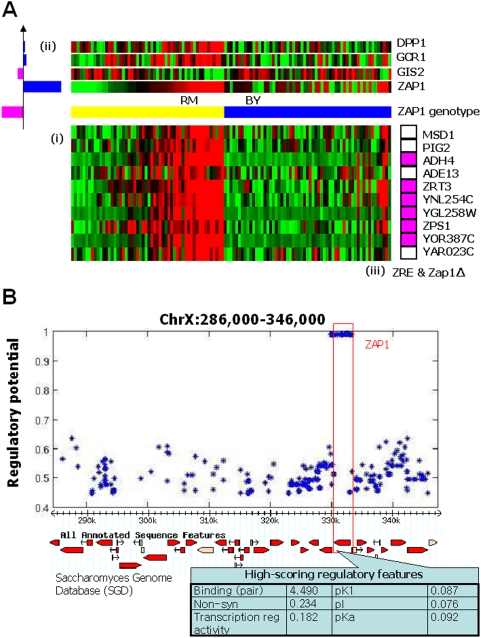
The Zap1 module.(A) (i) The mRNA expression profiles (log2 ratios) of the module's 10 target genes, where the rows are genes and the columns are strains. (ii) The module is regulated by five predicted regulators, where the two that have the most significant coefficients are the expression pattern of ZAP1 and a genetic region on chromosome 10 containing ZAP1. The bar on the left of each regulator represents its coefficient in the regulatory program: the length encodes its absolute value, purple represents a negative weight and blue a positive one. (iii) Six of the target genes (ADH4, ZTR3, YNL254C, YGL258W, ZPS1/YOL154W, and YOR387C) were identified as probable Zap1 targets based on the presence of a consensus ZRE element and RNA expression patterns [27]. (B) The genetic region on chromosome 10, with the inferred regulatory potentials for each of the SNPs it contains (Table S7). Also shown are the regulatory features that contributed the most to the selection of a SNP in Zap1 as the causal polymorphism: a known binding relationship between Zap1 and two of the target genes, the presence of non-synonymous coding changes and their effect on various protein properties, and the gene's annotation as having transcriptional regulator activity. All the other minor regulators of this module (Dhh1, Gcr1 and Gis2) are not located in this region; they are in chr 4, 16 and 14, respectively.